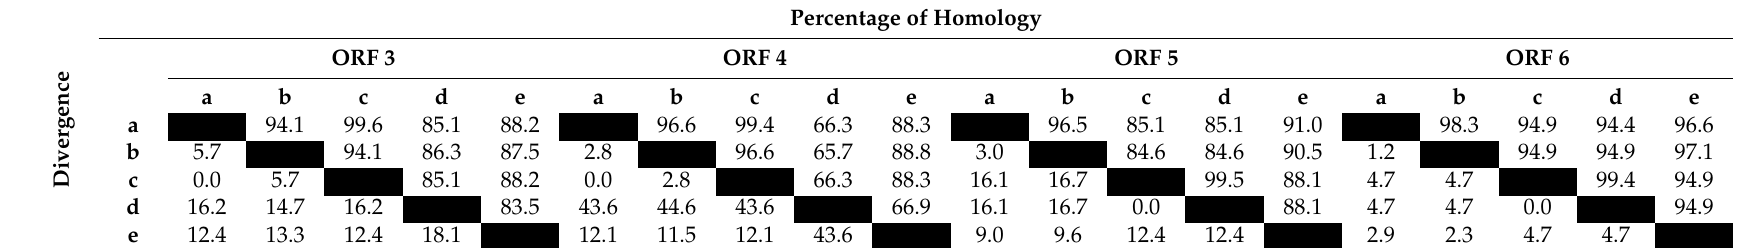
Table 1. Open reading frame (ORF)-wise percentage of amino acid homology between the different viruses used in this study.